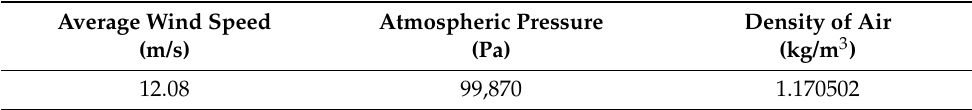
Table 1. Properties of air measured directly in the wind tunnel during